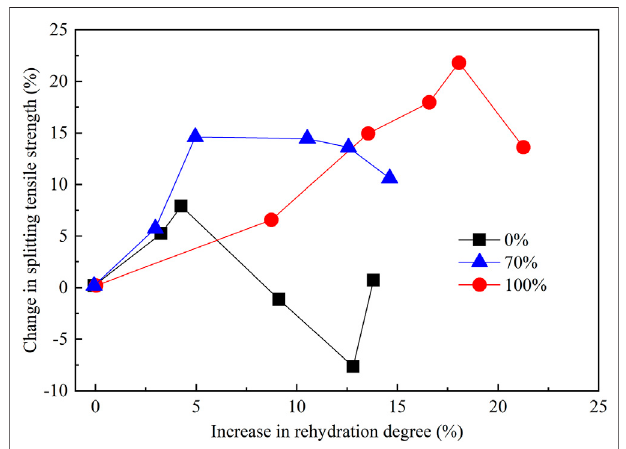
FIGURE 14 | Relationship between the cumulative capillary water absorption of UHPC-0 and its rehydration degree.